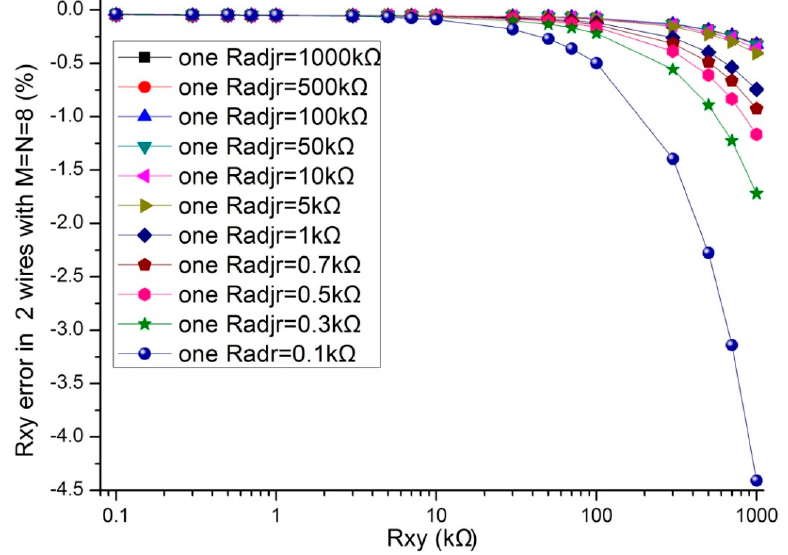
Figure 7. The R adjr effect on R xy errors in the two-wire VF-NSDE circuit.